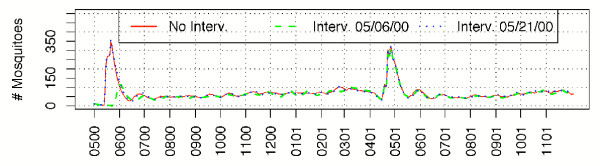
An. gambiae adult abundance with larval control intervention